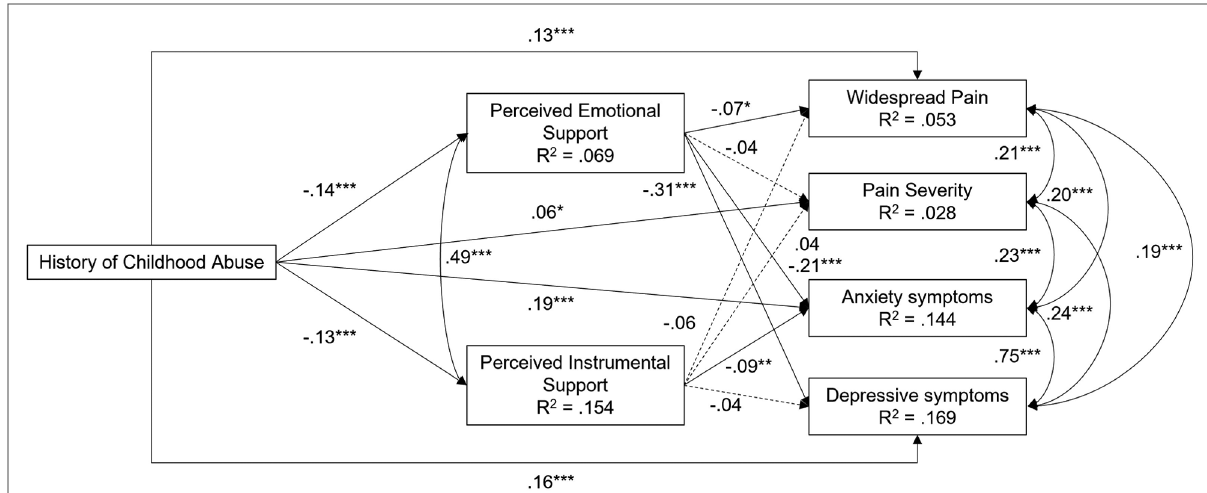
FIGURE 1 Final mediation model of the effect of history of childhood abuse on pain-related characteristics via perceived emotional support and perceived instrumental support ( n =1,542). Standardized coef fi cients are presented. Signi fi cance is determined using unstandardized coef fi cients and robust standard errors. Solid lines indicate signi fi cant paths. Dashed lines indicate nonsigni fi cant paths. ‡ p <.10. * p <.05. ** p <.01. *** p <.001. Covariates were included in estimation but are not shown.